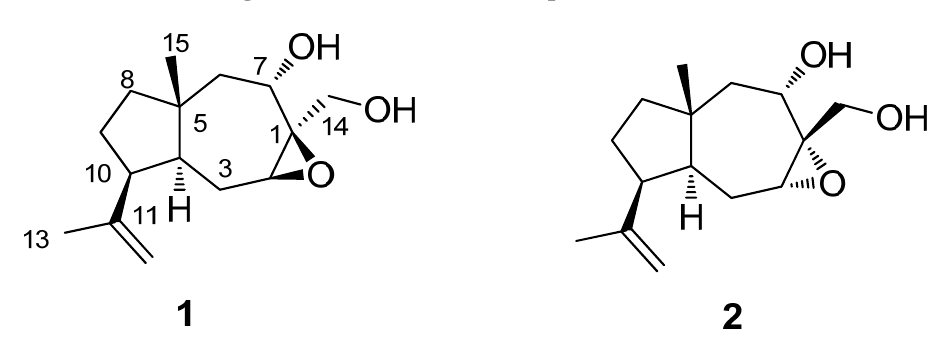
Figure 2. Structures of compounds 1 and 2